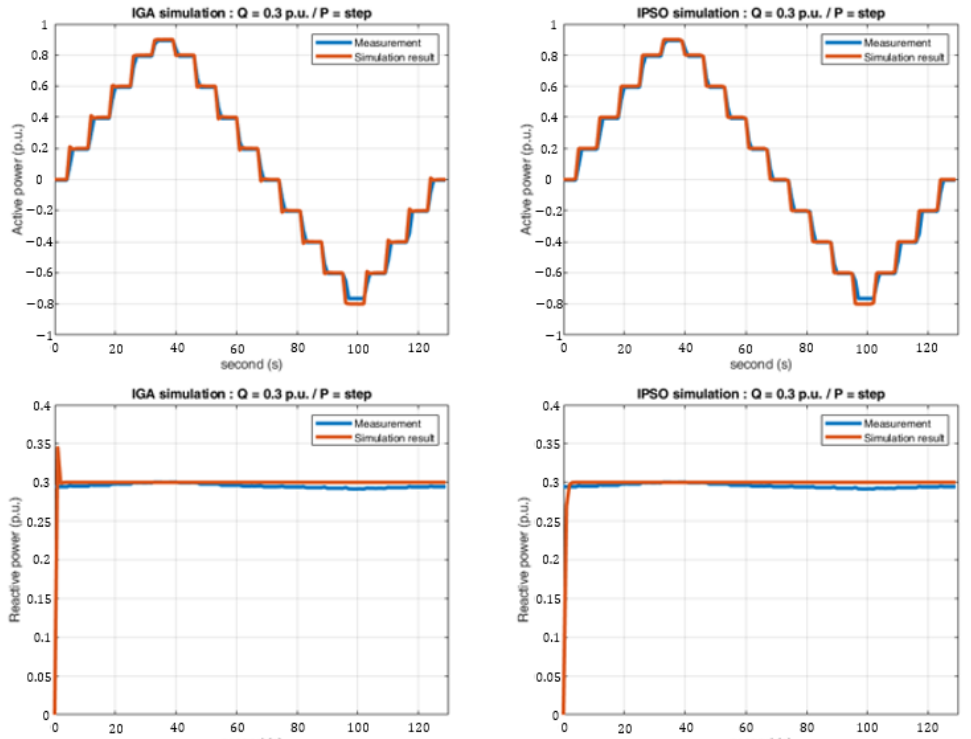
Figure 21. The IGA ( left ) and IPSO ( right ) fitting